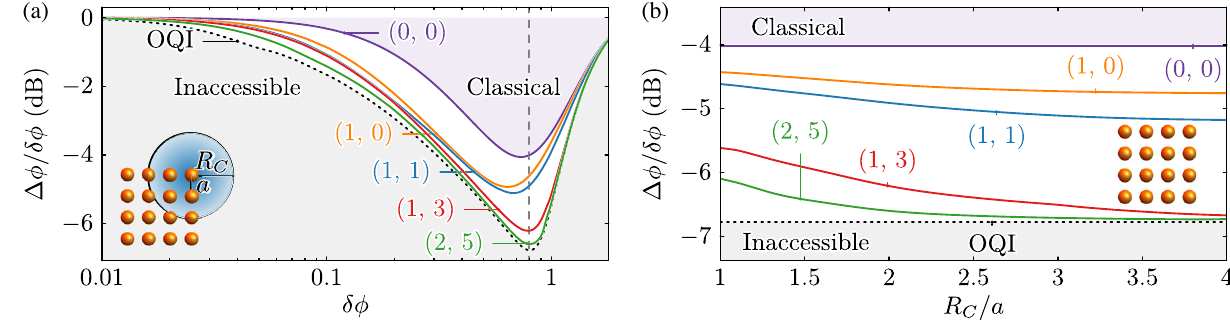
FIG. 8. Performance of the variationally optimized N ¼ 16 Ramsey interferometer on a 4 × 4 lattice interacting via finite range Rydberg dressing interactions (23) with interaction radii R in units of the array spacing a . Colored lines show the reduction of the C posterior phase distribution width Δ ϕ relative to the prior distribution width δϕ for variationally optimized circuits complexity ð n n with 3 ð n variational parameters. The performance of the optimal quantum interferometer (OQI)[31] is indicated by dotted lines. en þ de Þ The shaded areas indicate the classically accessible (purple) and the quantum mechanically inaccessible (gray) regions. (a) Prior width =a ¼ 2 . (b) Interaction range dependence of the optimal solution at a prior distribution width dependence of the optimized solution at R C δϕ ≈ 0 . 8 indicated by the vertical dashed line in